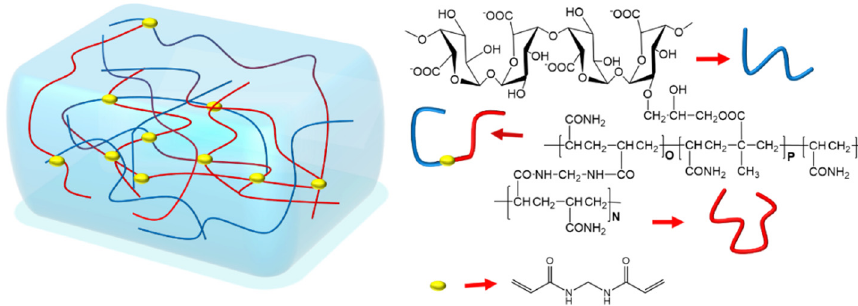
Figure 1: Schematic illustration of the preparation of GMA - SA - PAM hydrogels.